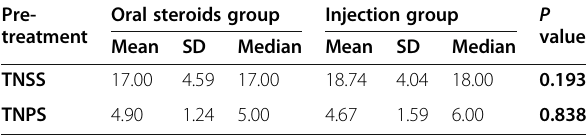
Table 1 Total nasal symptoms score (TNSS) and total nasal polyps score (TNPS) in both groups before receiving treatment Pre- Oral steroids group treatment